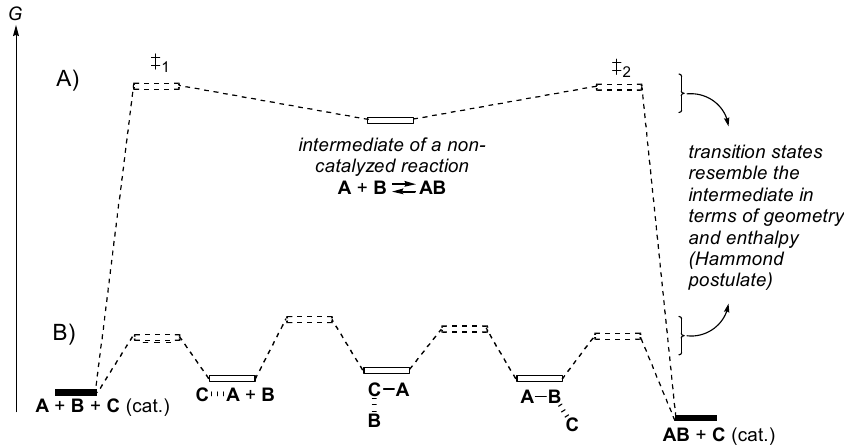
Figure 3. ( A ) Free energy diagram for an uncatalyzed reaction converting reactants A + B into product AB ; ( B ) for a reaction catalyzed by catalyst C .